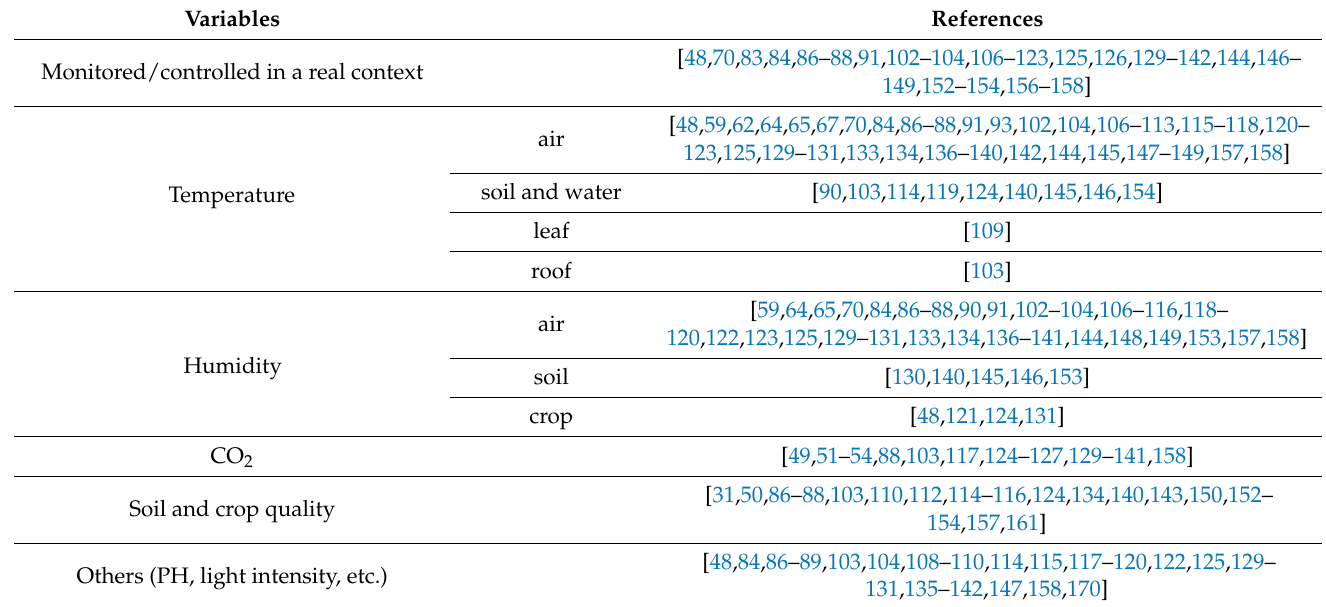
Table 2. Variables of the IoT-based agriculture monitoring and control system for the